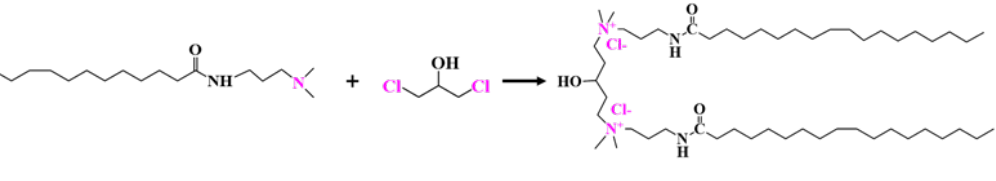
Figure 13. Synthesis principle of GOHAC.